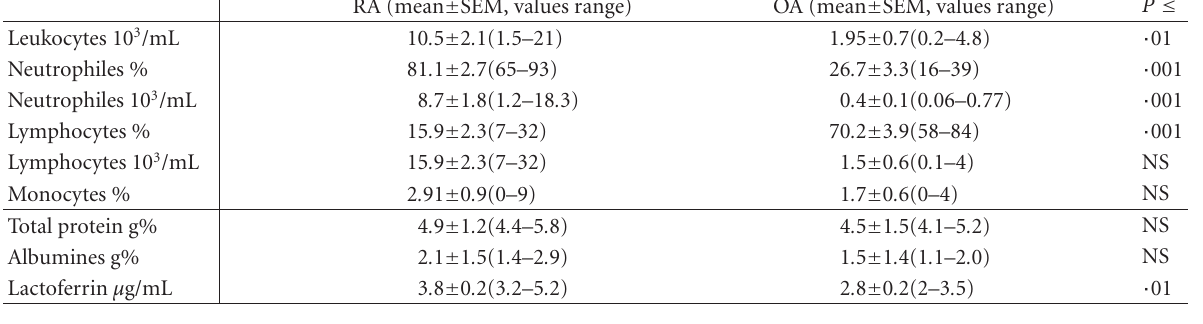
Table 1. Cellular and biochemical analysis of SF from RA and OA patients.